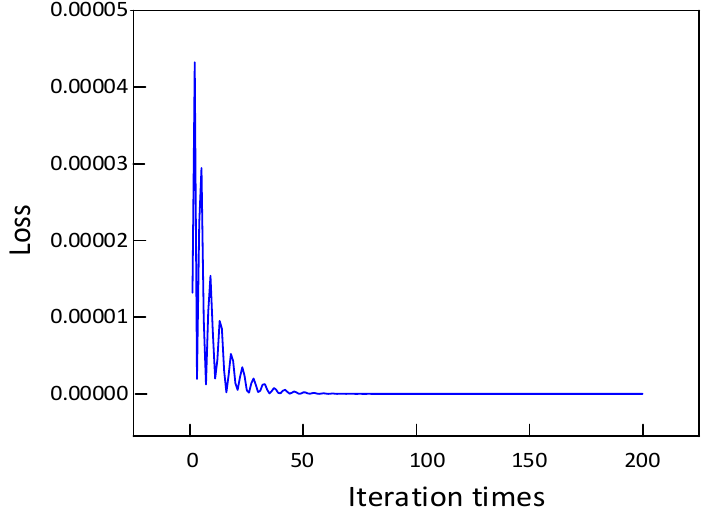
Figure 7. The loss-iteration times.